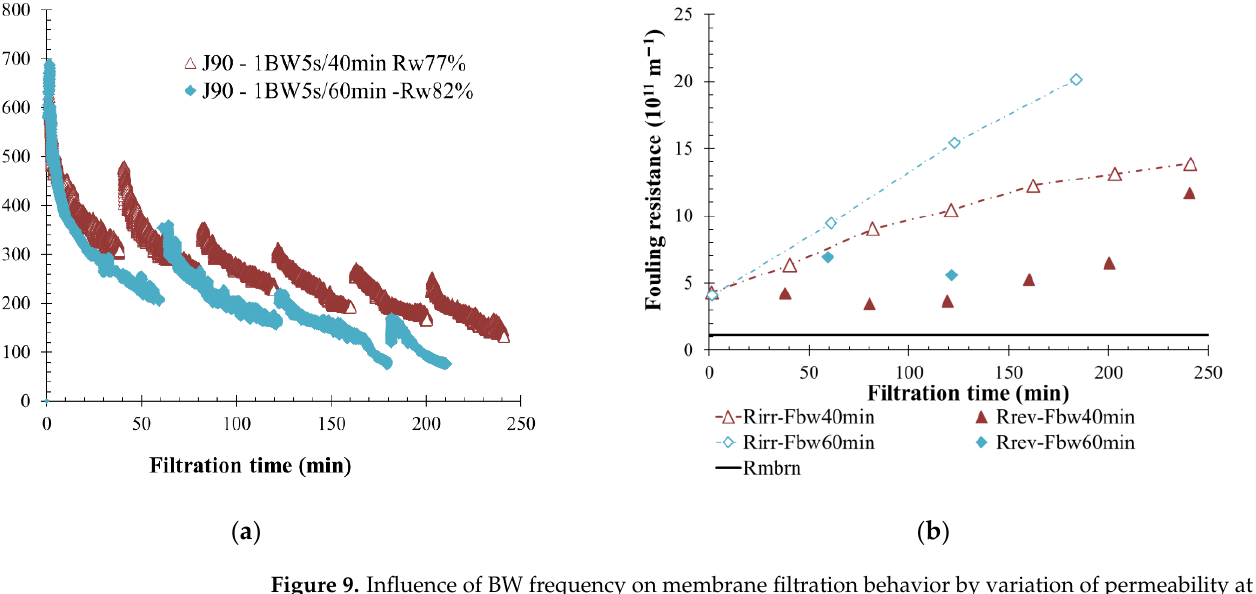
Figure 9. Influence of BW frequency on membrane filtration behavior by variation of permeability at 20 °C ( a ) and fouling resistance ( b ) throughout the time with permeate flux of 90 L h −1 m −2 and a BW duration of 5 s, every 40 min (red triangle) and every 60 min (blue diamond) are applied to the membrane. T = 20 ° C, feedwater from CC-KERGUELEN; SiC membrane 0.33 m 2 . Jxx is permeate flux at the xx value in L h −1 m −2 ; 1BW yy s/zz min where yy is the duration and zz the interval of filtration between two BF; and R w is the total recovery rate applied on the unit; R irr is irreversible resistance; R rev is reversible resistance and R mbrn is the membrane resistance.